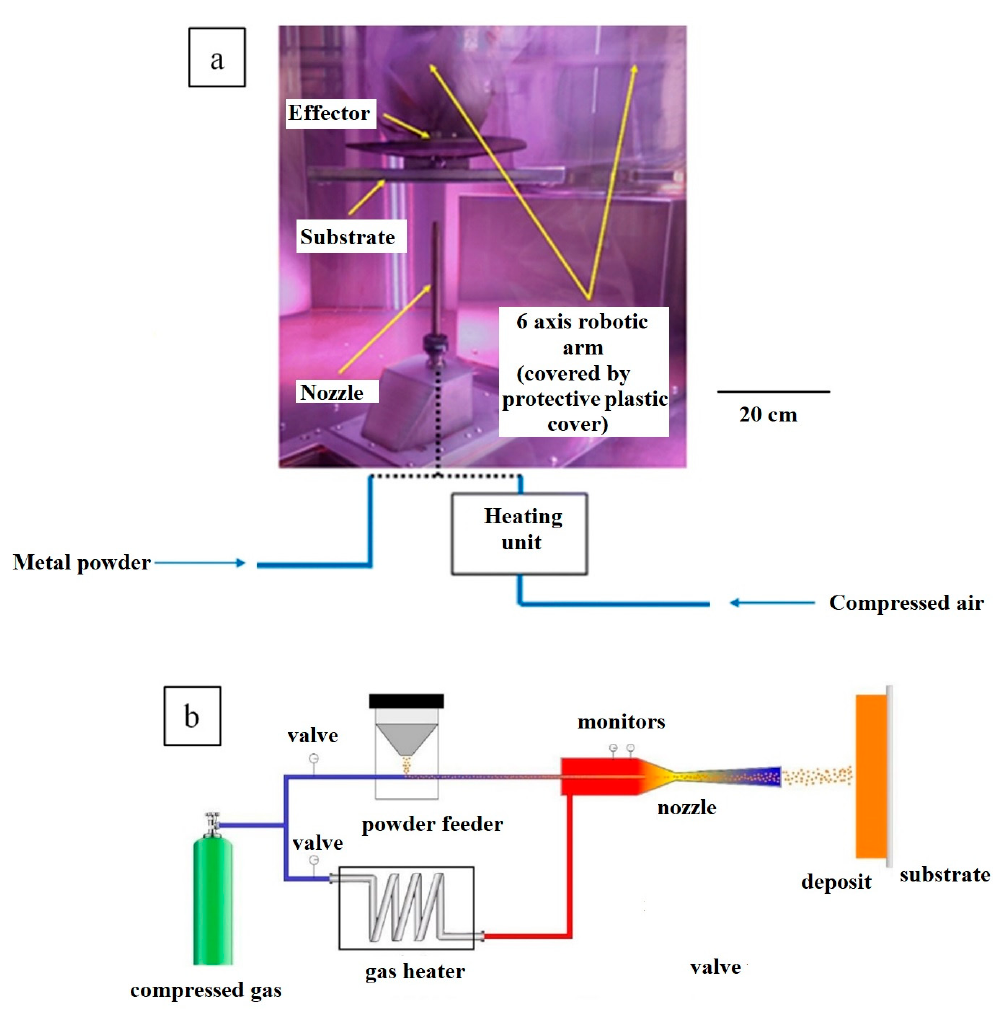
Figure 1. ( a ) A typical CS machine consisting of a powder delivery nozzle, a movable robot arm, and a substrate on which deposition is carried out; ( b ) schematic representation of the typical cold spray process. Presented with permission from